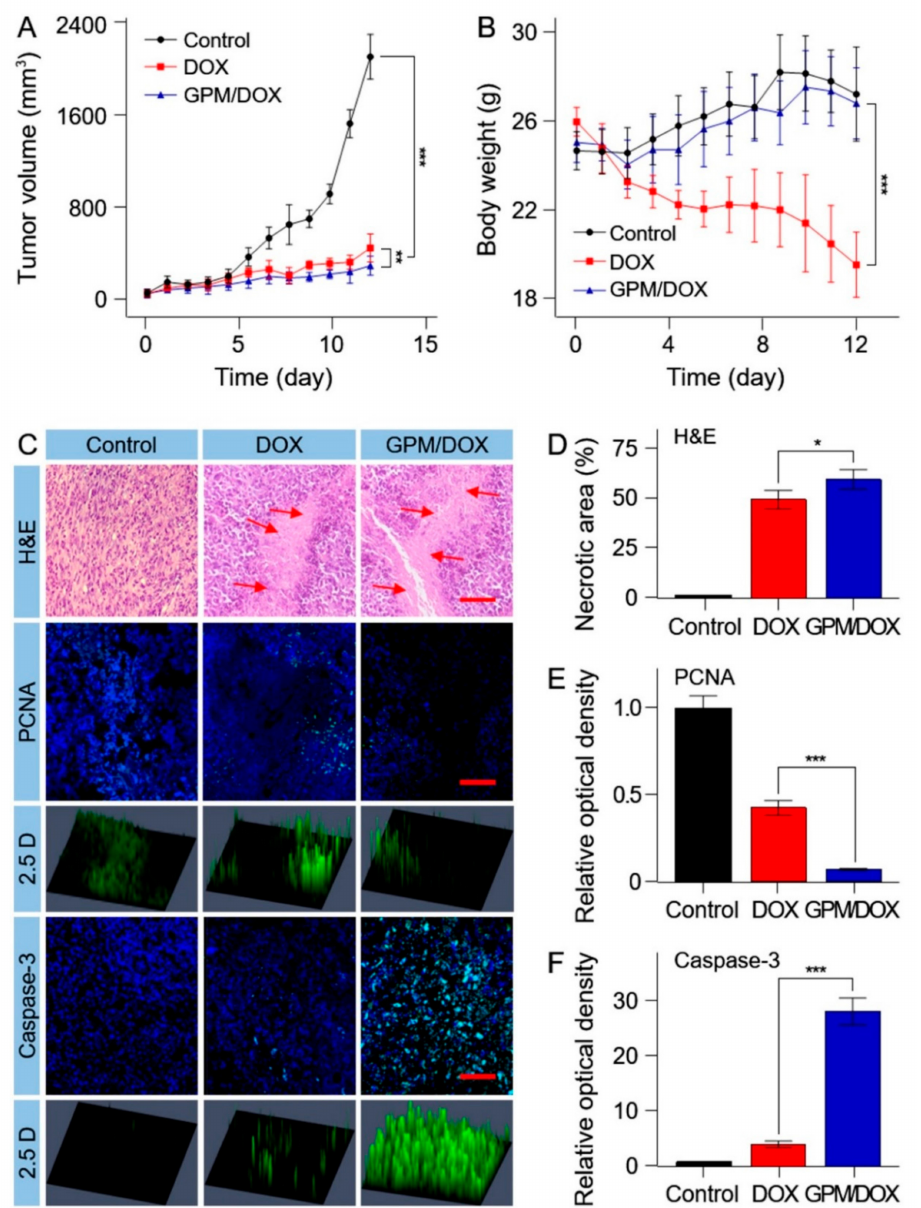
Figure 4. ( A ) Tumor volumes; ( B ) body weights of H22-xenografted mice after treatment with GPM/DOX or free DOX · HCl with normal saline as control; data were presented as mean ± SD ( n = 8; ** p <